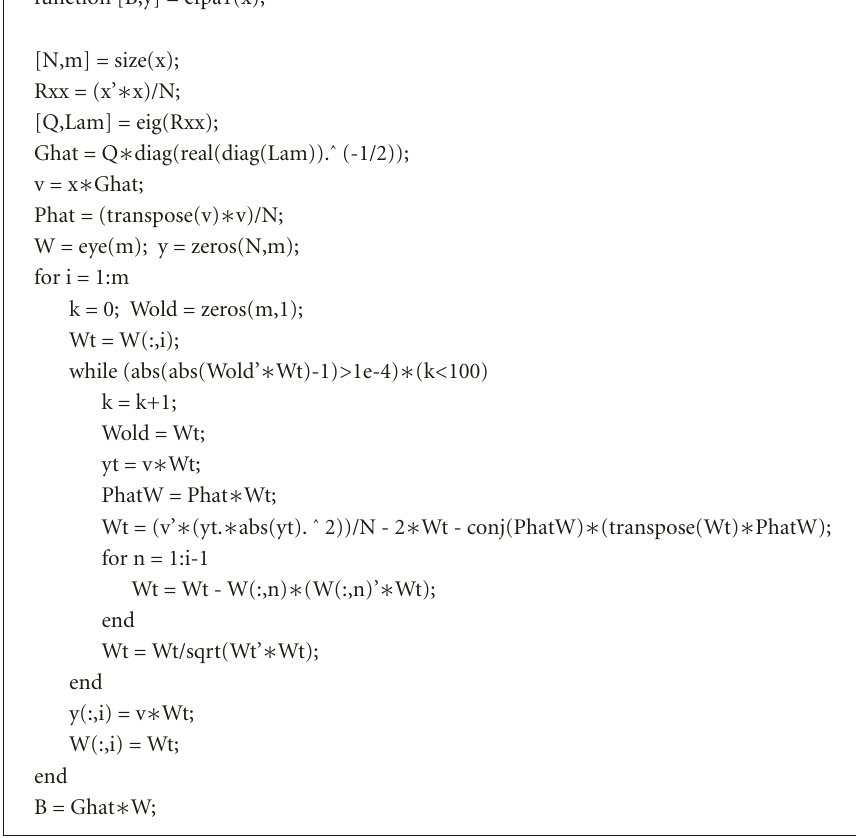
Algorithm 1: An implementation of our proposed fixed-point algorithm for complex-valued non-Gaussian source mixtures which uses sequential